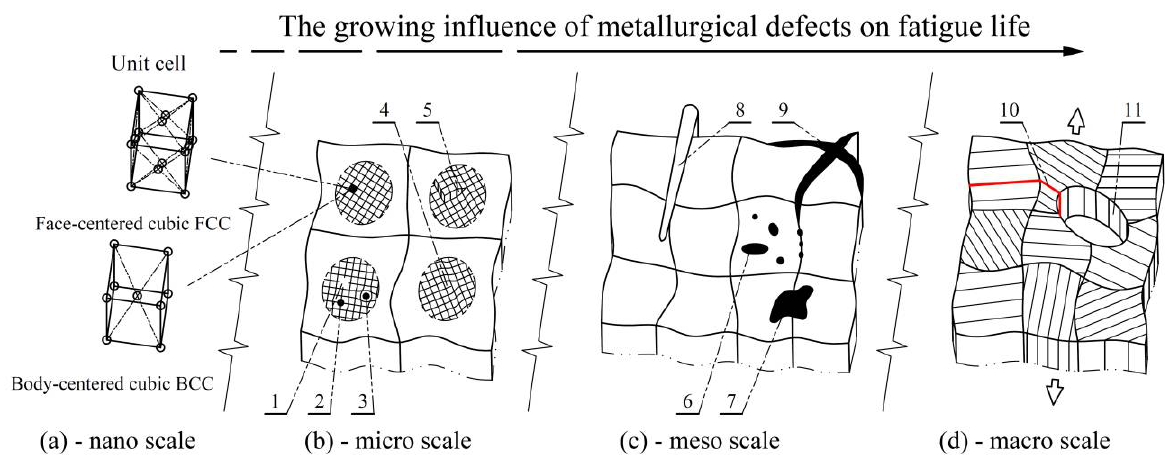
Figure 1. Material and structural defects on different scales of observation. ( a ) Crystal lattice; ( b ) vacancy, substitutional and interstitial atom, edge and screw dislocation; ( c ) impurities, particles; ( d ) crack and void.